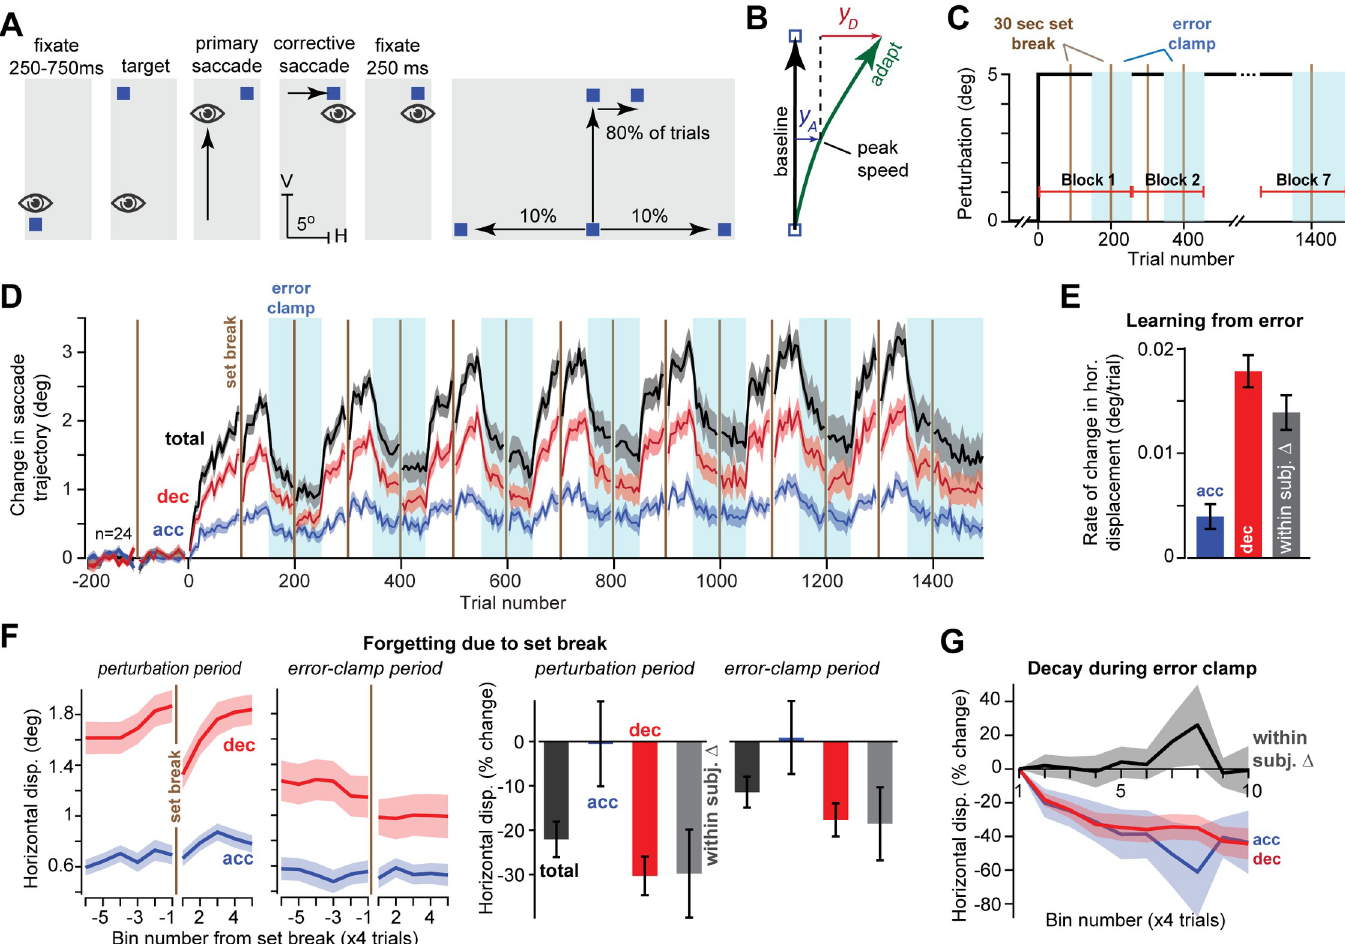
Fig 1. Acceleration and deceleration period commands exhibit some of the properties of the fast and slow system. A . Experiment 1 trial structure. Following a vertical primary saccade, subjects experienced a rightward horizontal endpoint error. B . To quantify adaptation, we measured the horizontal displacement of the adapted saccade with respect to baseline saccades. We integrated horizontal eye velocity over the acceleration and deceleration periods to determine the displacement during each period. C. Training blocks. Each block consisted of four periods: initial adaptation, set break (brown line), re-adaptation, error clamp. D . Horizontal displacement during the acceleration period was smaller than during the deceleration period, but exhibited little or no forgetting at set breaks. E . Trial-to-trial rate of change in the horizontal displacement produced by the acceleration and deceleration period commands during the perturbation blocks. Rate of change was faster in the deceleration period. F . Effect of set break on the horizontal displacement in the perturbation blocks and error clamp blocks. At left we show adaptation aligned to set breaks and averaged across all periods. Bin size is 4 trials. Decay was much greater in deceleration period commands. At right, we calculated the percent loss during set breaks in the perturbation and error clamp periods (depicted at left). G . Decay in the acceleration and deceleration period commands during the error clamp period. Error bars are between subject SEM. Bin size is 4